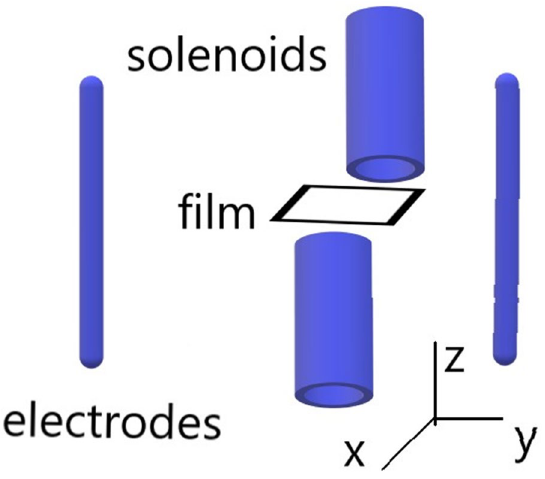
Figure 1. Sketch of field configuration and experimental setup. Note that two gaps might be filled with high- permittivity insulator, which can also act as an “holder” holding the film. If the “holder” is undertaken by thin dielectric substrate, suitably adjusting charge current in coils/solenoids can still warrant the metallic film to feel a magnetic slope. Note that cross-sections of solenoids are of square shape, which is not reflected in the scheme (due to the limit of plot software) and hence have to be stated clearly